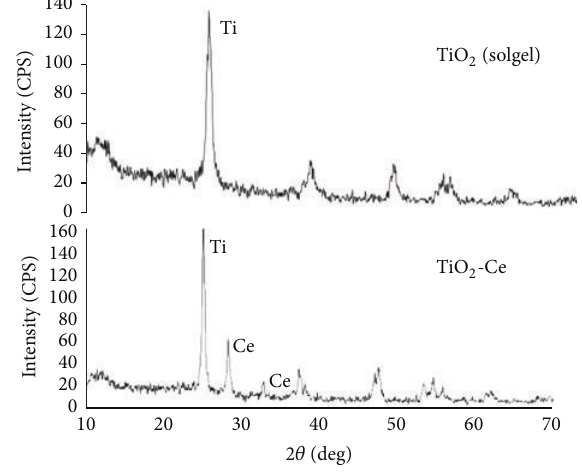
Figure 1: XRD analysis of TiO 2 and TiO 2 -Ce.